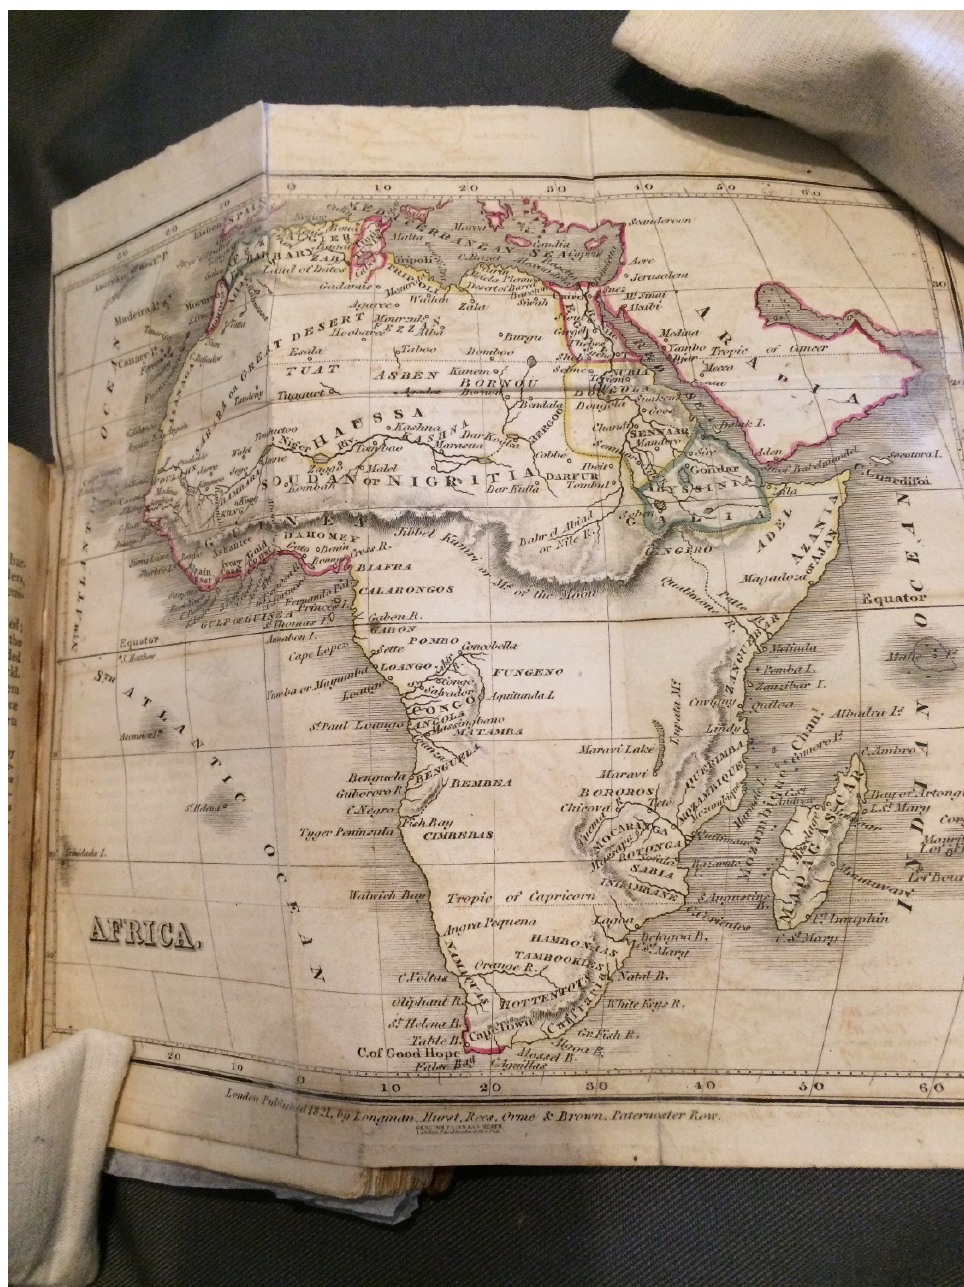
Figure 7. Map of Africa from the Brontë copy of Goldsmith’s Geography (Rev. J. Goldsmith 1823).